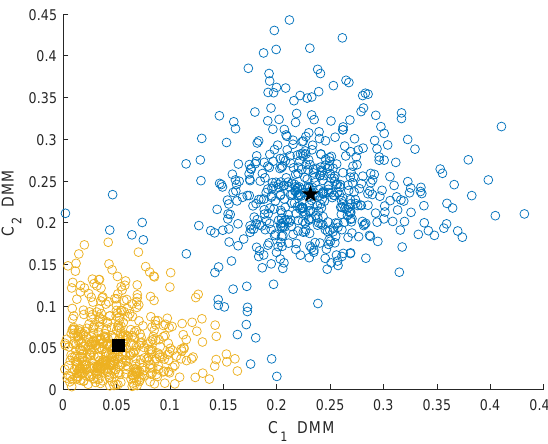
Figure 5. Clustering effect of the DMMs under the Rician channel.